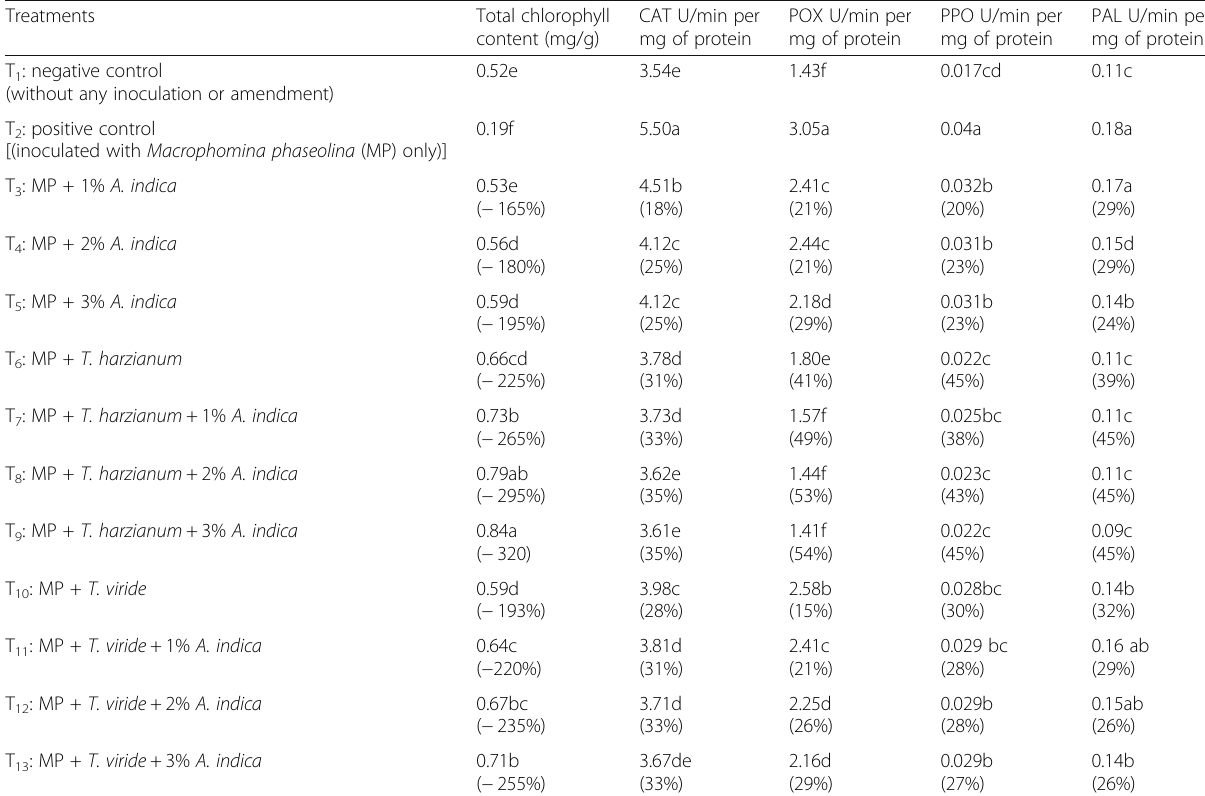
Table 4 Effect of Macrophomina phaseolina , soil amendment, and Trichoderma spp. on physiological attributes in Vigna unguiculata